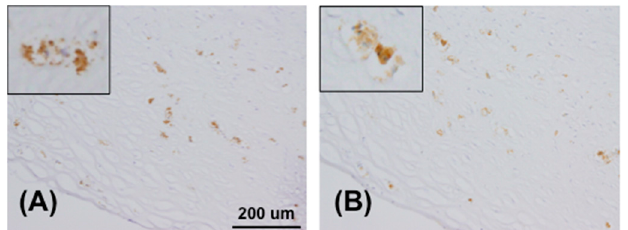
Figure 4. Immunohistochemical staining of human atherosclerotic lesion. Positive reactions were seen for the accumulation of GA-pyridine (brown). The sections were treated with anti-GA-pyridine monoclonal antibody, 2A2 ( A ) and AGE73scFv ( B ), respectively.